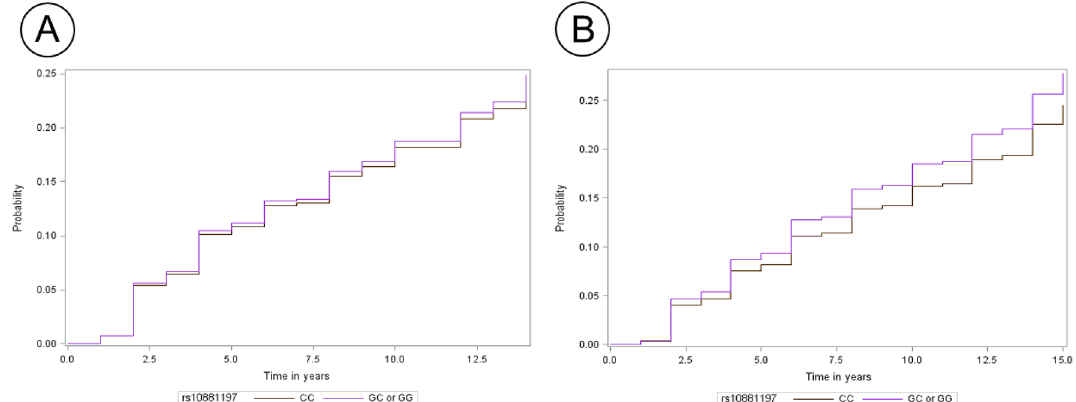
Figure 1. Cumulative incidence of type 2 diabetes by carbohydrate intake. ( A ) Comparison of cumulative incidence between rs10881197 CC and rs10881197 GC or GG genotypes for carbohydrate intake ≤ 65% of total energy intake. ( B ) Comparison of cumulative incidence between rs10881197 CC and rs10881197 GC or GG genotypes for those with carbohydrate intake > 65% of total energy